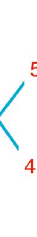
Figure 35. Numbering of pentagon, vertices in blue, sides in red.